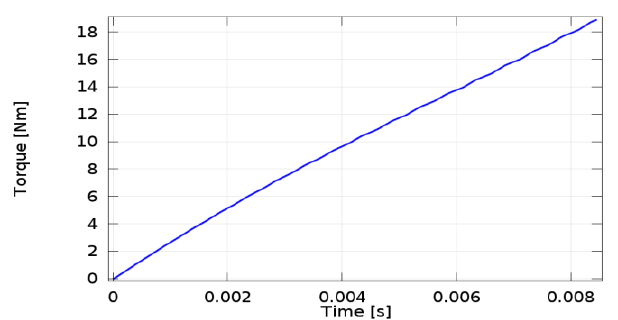
Fig. 18. Calculated torque from the coupled COMSOL